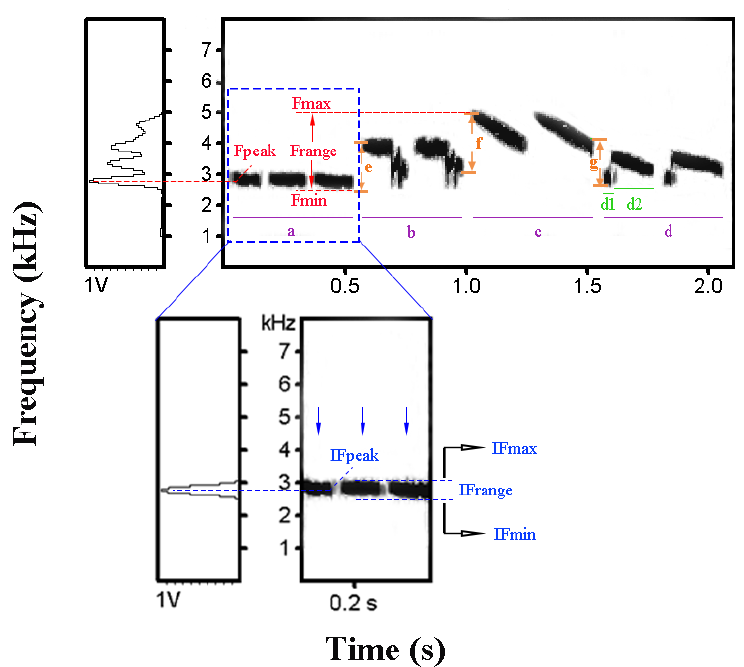
Figure 2. A typical song of the Yellow-breasted Bunting Emberiza aureola showing an obvious introductory phrase at the beginning, a repeated phrase in which the same syllable appears repeatedly and modulation frequency of adjacent phrases. “a” represents the introductory phrase. “a” “b” “c” and “d” indicate different repeated phrases. The blue arrows indicate three syllables in repeated phrase “a” “d1” and “d2” indicate different elements that are discontinuous tracks in the sonogram of a syllable. “e” “f” and “g” show frequency modulation between neighboring phrases. As for “f” MFpeak is equal to the difference in the peak frequency of “b” and “c”, which is divided by the duration from the start of “b” to the end of “c”; MFrange is equal to the difference in the frequency bandwidth of “b” and “c”, which is divided by the duration from the start of “b” to the end of “c”; and MFmaxmin is equal to the difference in frequency between the end of “b” and the start of “c”, which is divided by the interval between “b” and